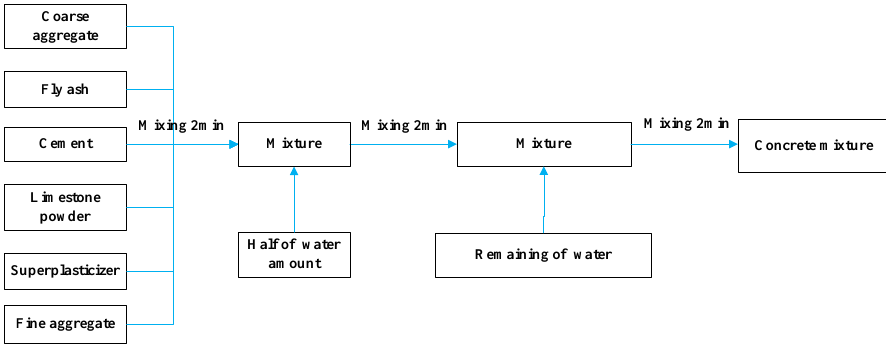
Figure 6. Mixing process of concrete.